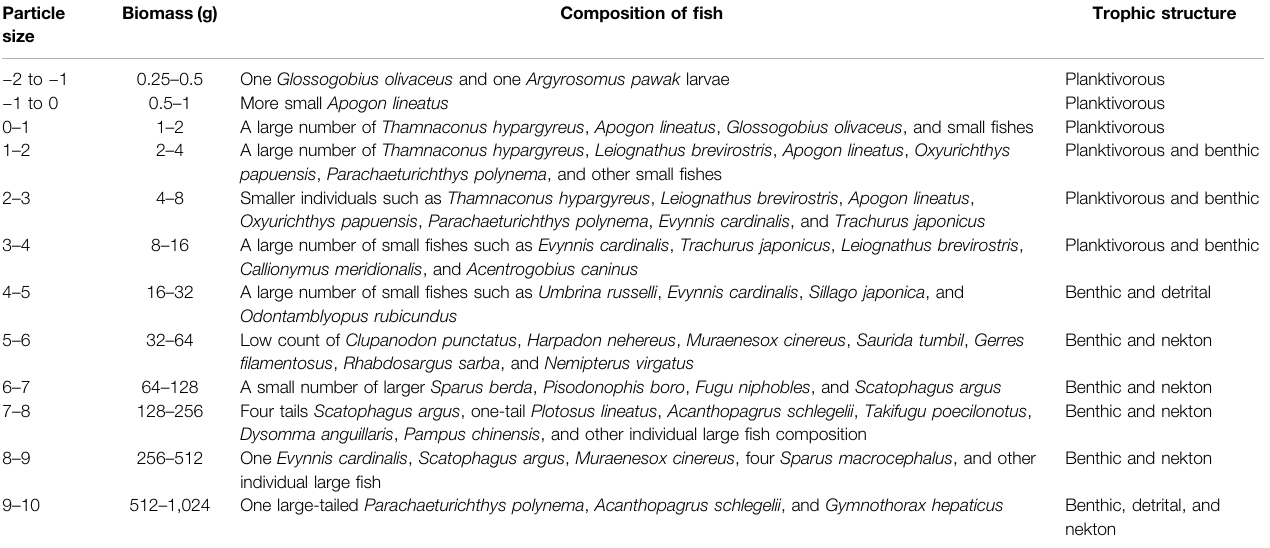
TABLE 4 | Fish composition according to the particle